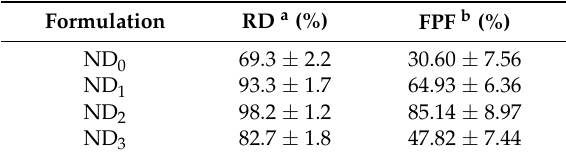
Table 3. Aerosolization performance of NTM DPIs ( n = 3).